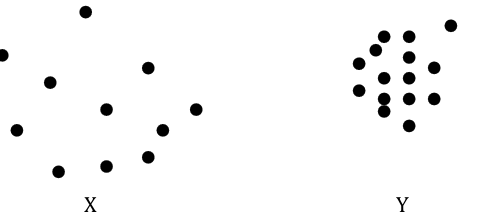
Figure 4. Example of two classes X and Y with different